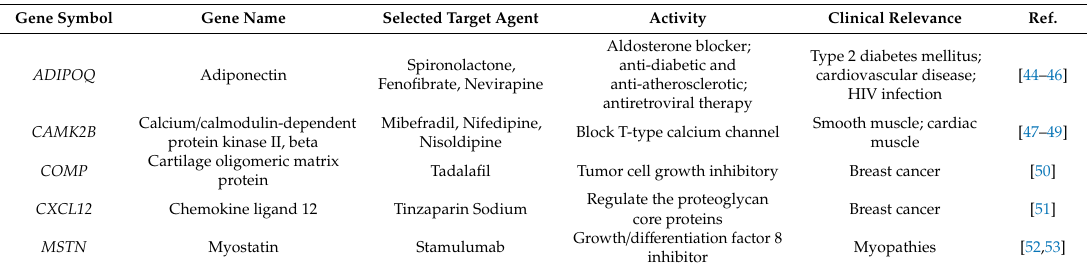
Table 4. Potential target agents identified based on protein–protein interaction networks of deregulated genes in cancer